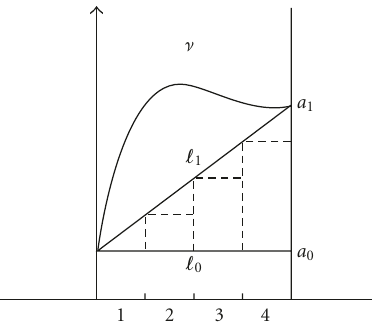
Figure 9: Frame signal length approximation.